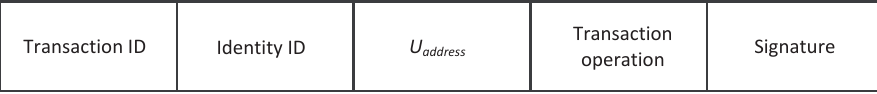
Fig. 1 Blockchain transaction data